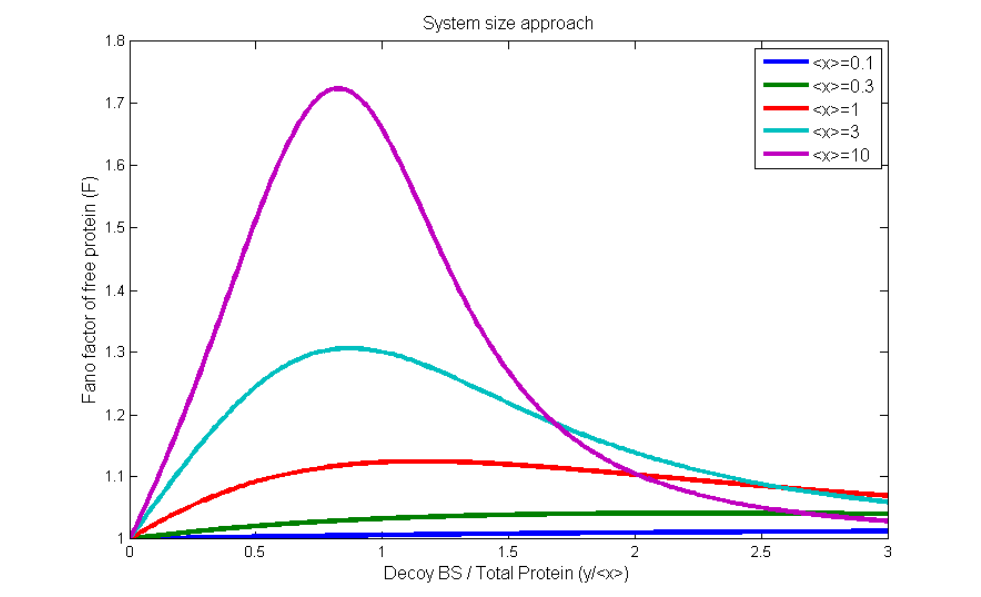
Fig. 6: Fano factor for large system size.